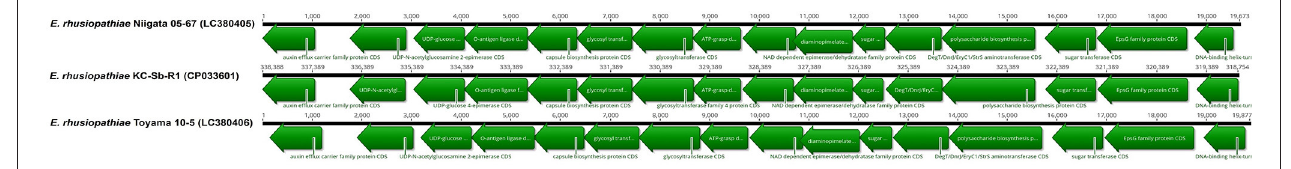
FIGURE 4 | Comparison of the serovar-defining chromosomal regions of the E. rhusiopathiae strain KC-Sb-R1 and other serovar 2/15 strains (Niigata 05-67 and Toyama 10-5)* available in the GenBank database. *The strain Quitz 262 was not included, as its complete nucleotide sequence is not available in the GenBank